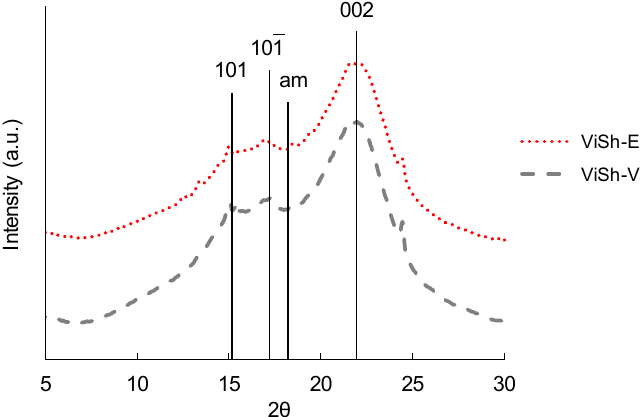
Figure 2. X-ray di ff ractograms of ViSh-V (virgin) and ViSh-E (exhausted), “am” stands for the Figure 2. X-ray diffractograms of ViSh-V (virgin) and ViSh-E (exhausted), “am” stands for the amorphous amorphous scattering.